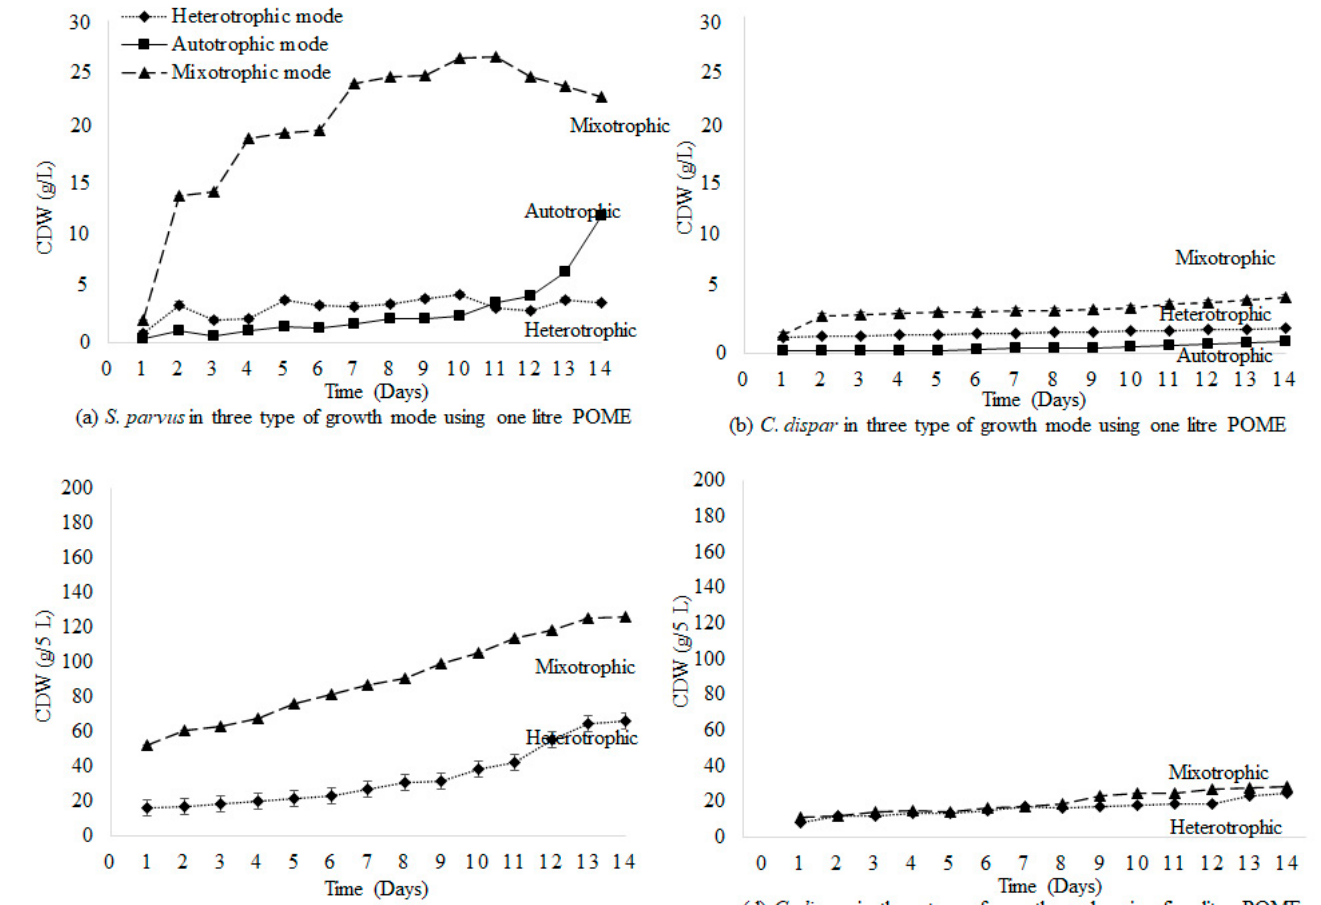
Figure 3. The CDW of Scenedesmus parvus and Coccomyxa dispar cultivated in three types of growth mode using working volumes of ( a , b ) 1 L of POME and ( c , d ) 5 L of POME.